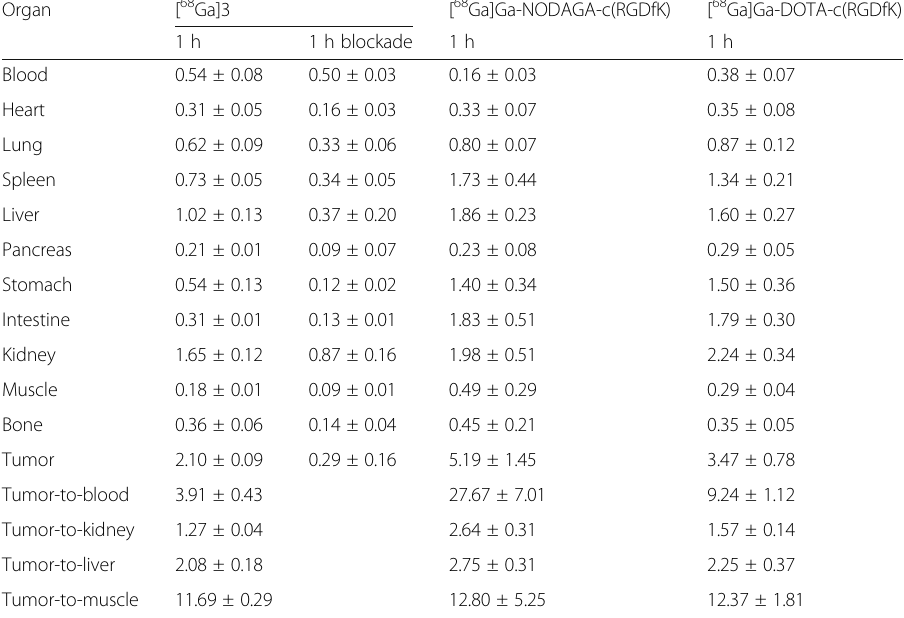
Table 1 Ex vivo biodistribution of [ 68 Ga] 3 in mice bearing α v ß 3 -positive U-87 MG tumors at 1 h p.i. along with blocking studies in comparison to [ 68 Ga]Ga-NODAGA-c(RGDfK) and [ 68 Ga]Ga-DOTA- c(RGDfK) (data taken from ref. Dumont et al. 2011). Data are expressed as %IA g − 1 and represent mean ± SD ( n = 5) Organ